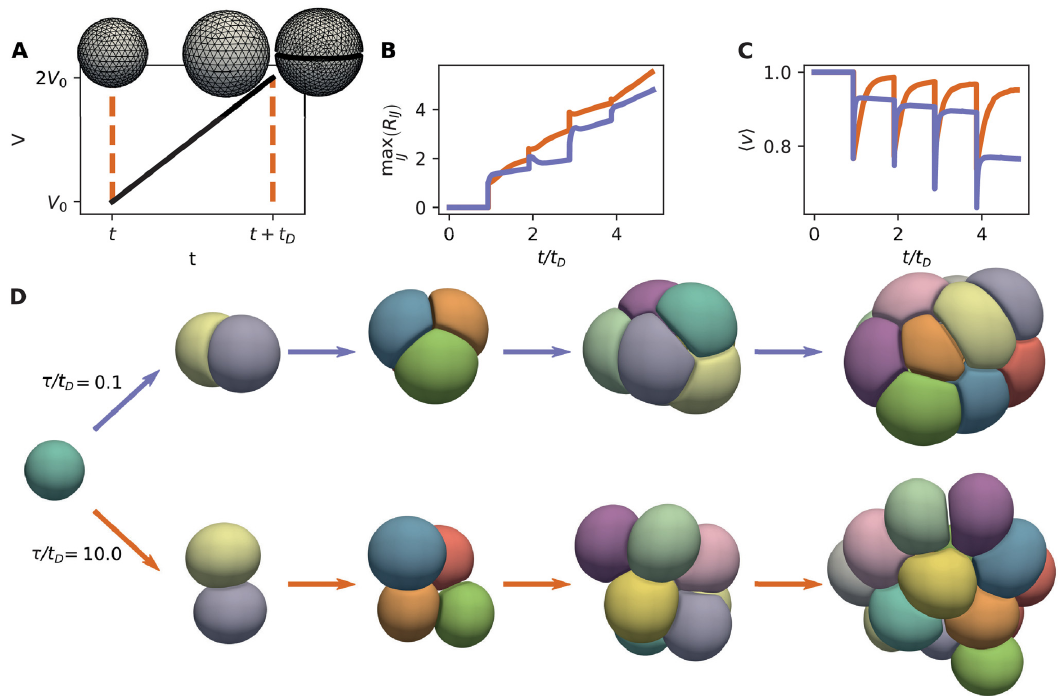
Fig 7. Growth of small cell aggregates, driven by synchronous cell divisions and cell volume increase ( ~ D ¼ 0 : 15 , ~ κ ¼ 10 (cid:0) 2 , ~ ℓ ¼ 0 : 04 ). (A) Each cell doubles its volume between birth and division, over a cell cycle time t splitting the mother cell with a plane passing through the cell centre, and generating two daughter cells separated by a distance d � ( d � /2 from the division plane). (B-D) Simulation results for two values of the ratio τ / t D . (B): Largest centre-to-centre cell distance max h , as a function of time. Jumps correspond to cell division events. (C) Average reduced volume h v i as a function of time. I , J i R IJ (D) Snapshots of simulations of two growing